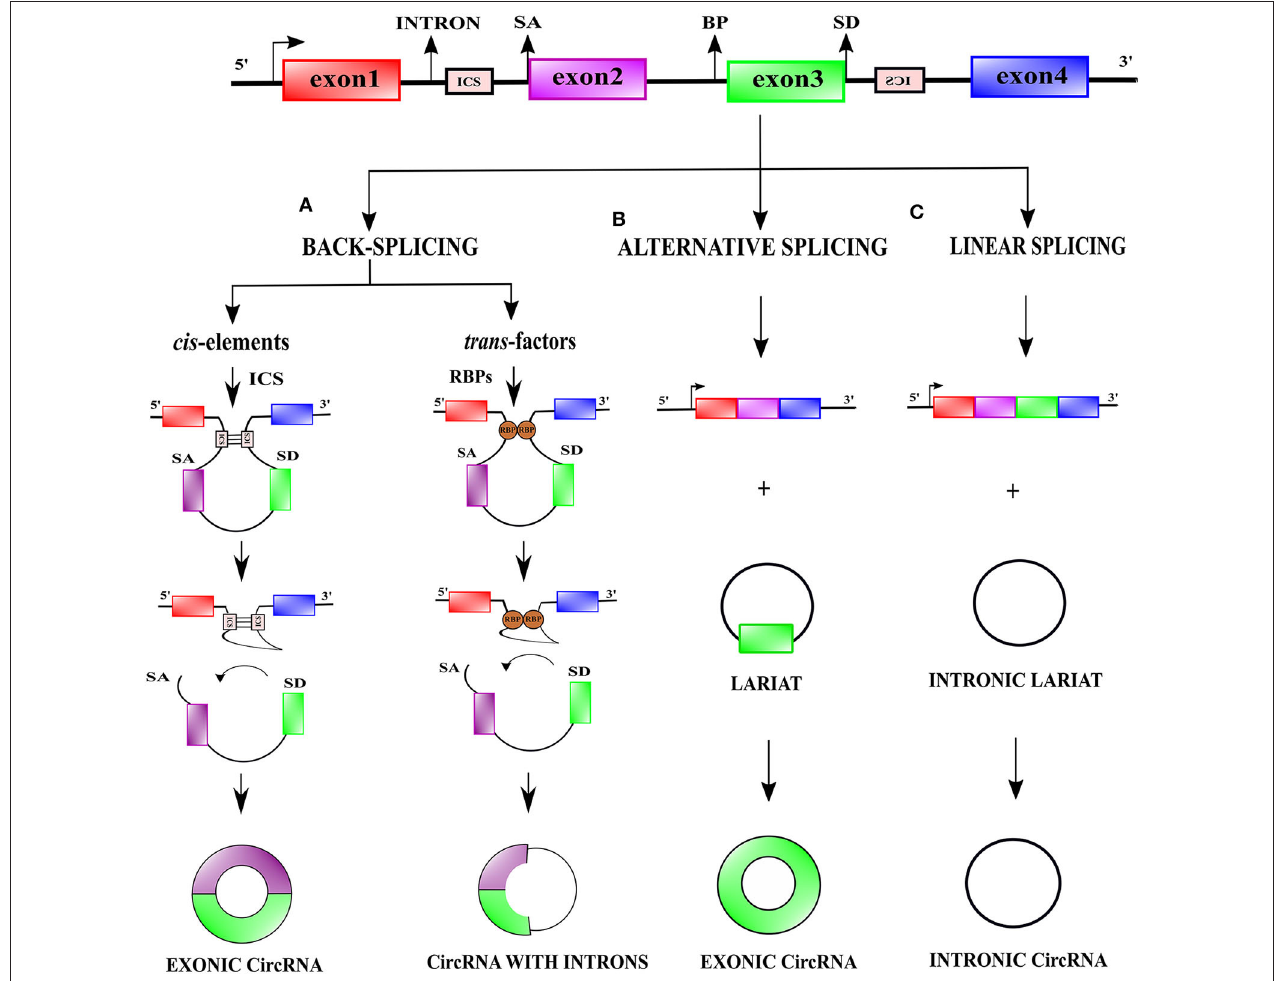
FIGURE 1 | Biogenesis of circular RNAs. (A) During transcription, linear and back-splicing of exons rival each other. Back-splicing is facilitated by long flanking introns, cis-elements i.e., intronic complementary elements (ICS), and trans-factors i.e., RNA-binding proteins (RBPs). To facilitate back-splicing, a downstream splice-donor (SD) site is brought in close vicinity with an upstream splice-acceptor (SA) site via base-pairing interactions between ICS or dimerization of RBPs. An upstream branch point (BP) nucleophilically attacks a downstream SD site, which thereafter nucleophilically attacks an upstream SA site, resulting in the creation of exonic circRNAs or exon-intron circRNAs. (B) Alternative splicing events like exon-skipping often generate skipped exon bearing lariat precursors, which can participate in the genesis of exonic circRNAs. (C) Intronic lariat precursors generated by linear canonical splicing can escape lariat debranching and serve as a source for intronic